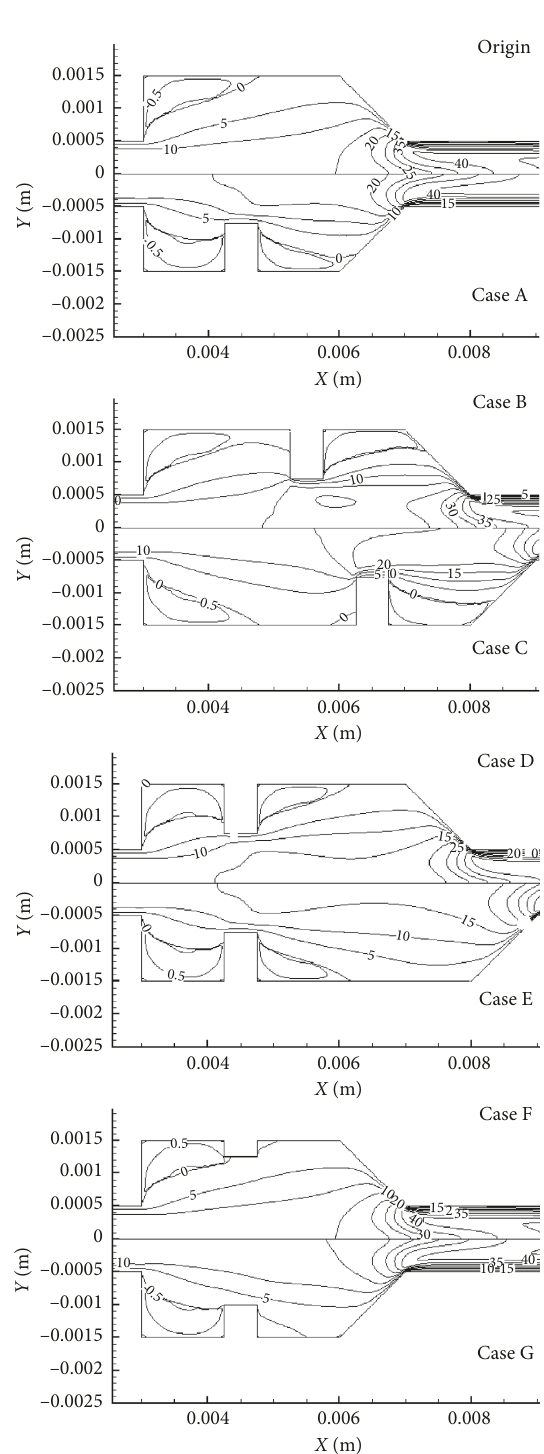
Figure 6: Contours of the longitudinal velocity component in the region near the cavities. The inlet velocity is